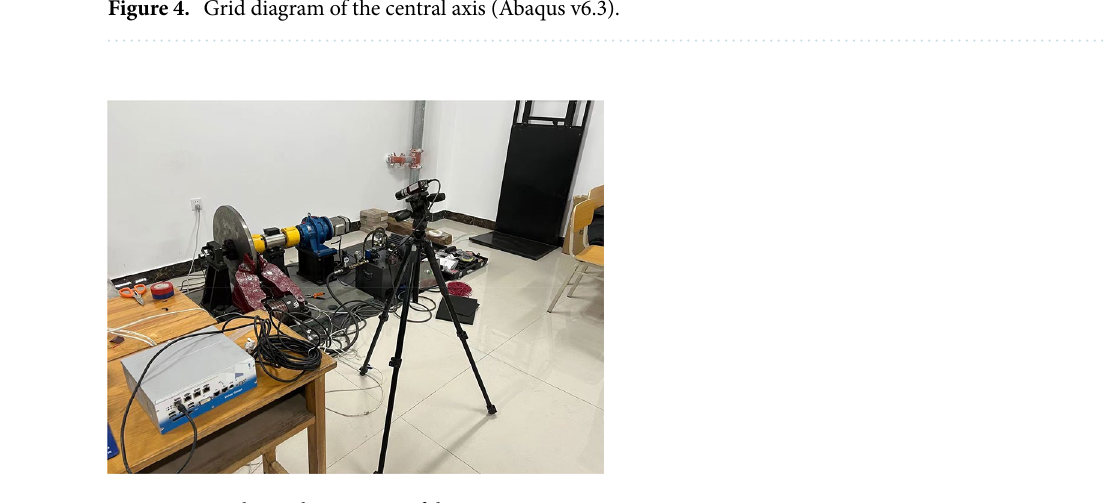
Figure 5. Mechanical properties of disc